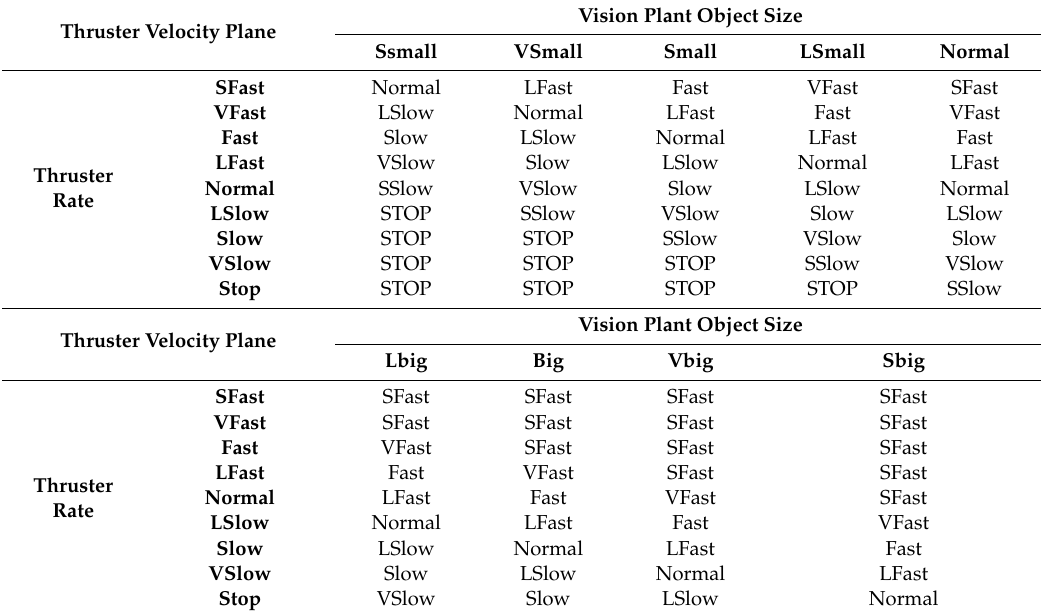
Table 4. Rules for thruster revolution